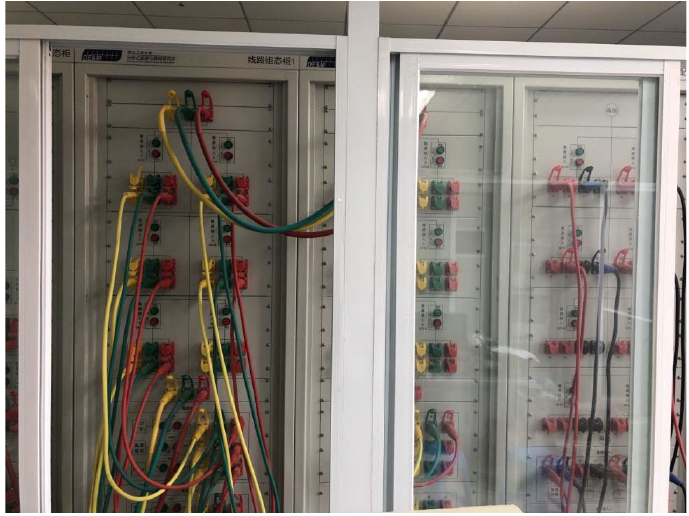
Figure 4. Experimental platform for electronic system simulation.